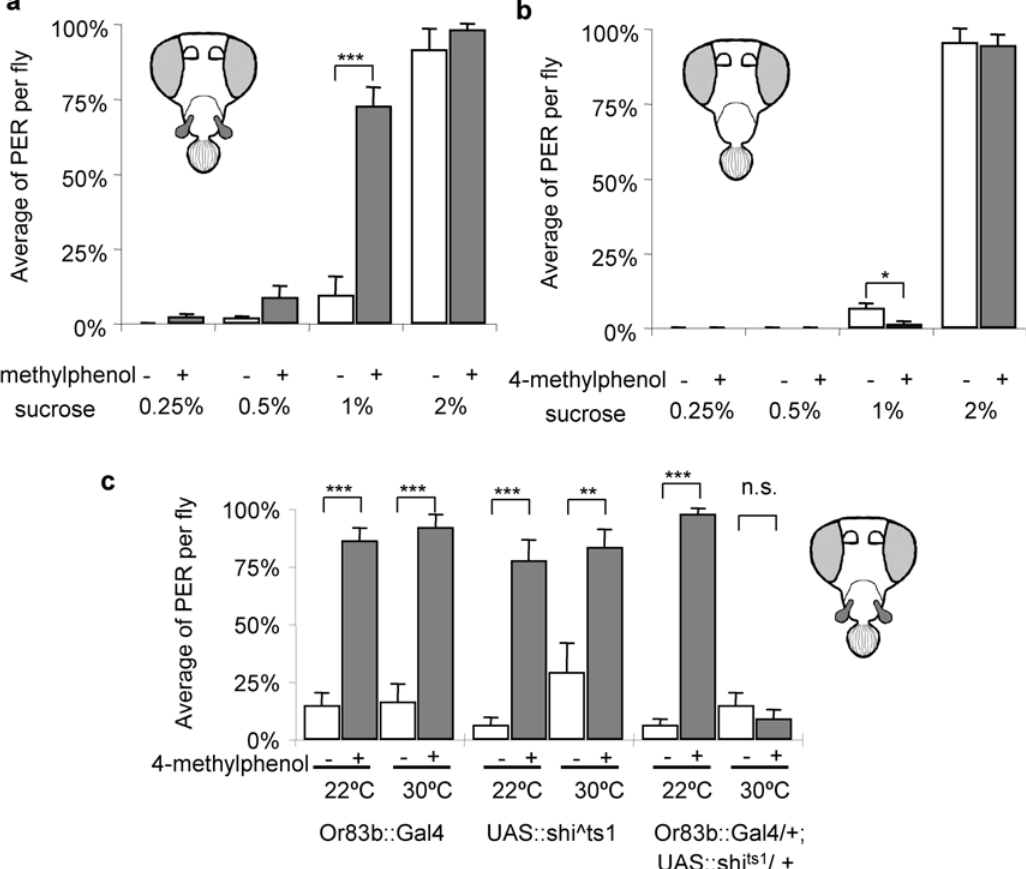
Figure 2. Effect of an odorant 4-methylphenol on PER. Wild type flies without a) antenna (Ant 2 , MP + ), b) no olfactory organs (Ant 2 , MP 2 ) are tested. c) Antenna less flies (Ant 2 , MP + ) of Or83b::Gal4, UAS::shibire ts1 and the progeny from crossing these two lines (Or83b::Gal4 6 UAS::shibire ts1 ) were tested with 1% sucrose. + / 2 indicates the presence/absence of 4-methylphenol (0.2% v/v) in the sucrose solution. For all figures: Error bars are S.E.M. n=7 to 14. Paired stutdent’s t- test were done on arcsin converted values. * : p , .05, ** : p , .01, *** : p ,